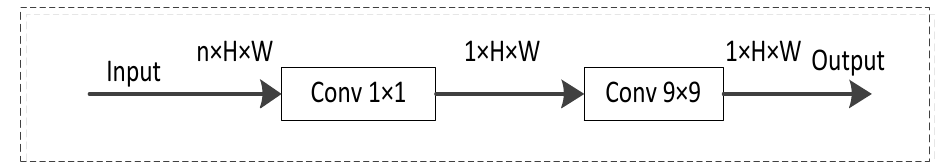
Figure 4. G_conv module. Conv 1 × 1 denotes general convolution operations with kernel = 1. Conv 9 × 9 denotes general convolution operations with kernel = 9.